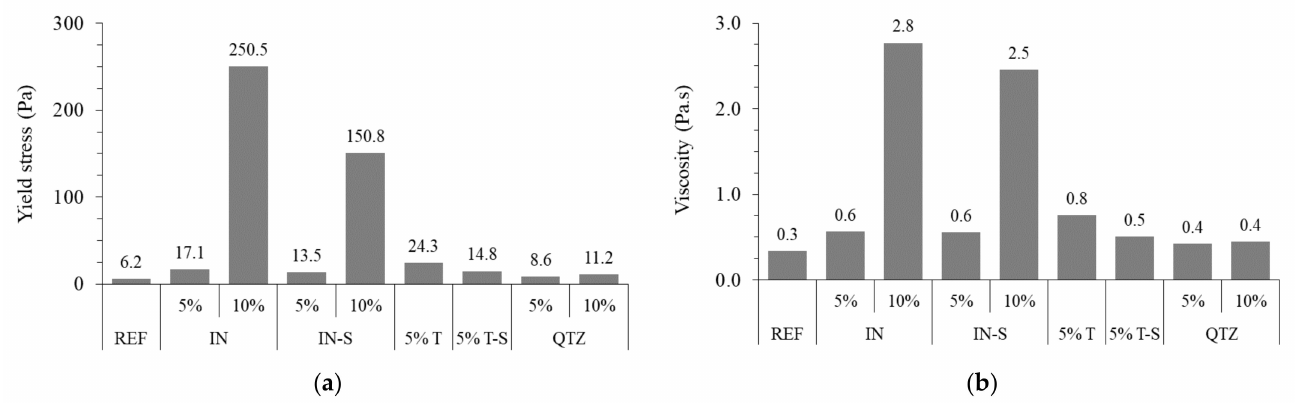
Figure 5. Rheological properties of the pastes: ( a ) yield stress; ( b ) viscosity. Note: IN = in natura, S = saturated; T = treated; QTZ =